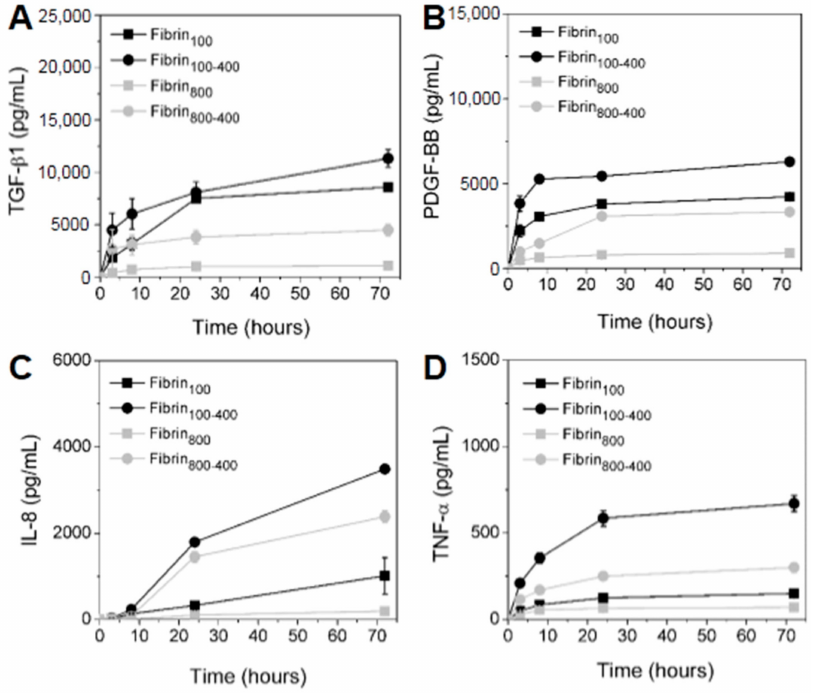
Figure 5. Kinetics of the GFs ( A ) TGF- β 1, ( B ) PDGF-BB, and the inflammatory cytokines ( C ) IL-8 and ( D ) TNF- α released from the nanofibers over 72